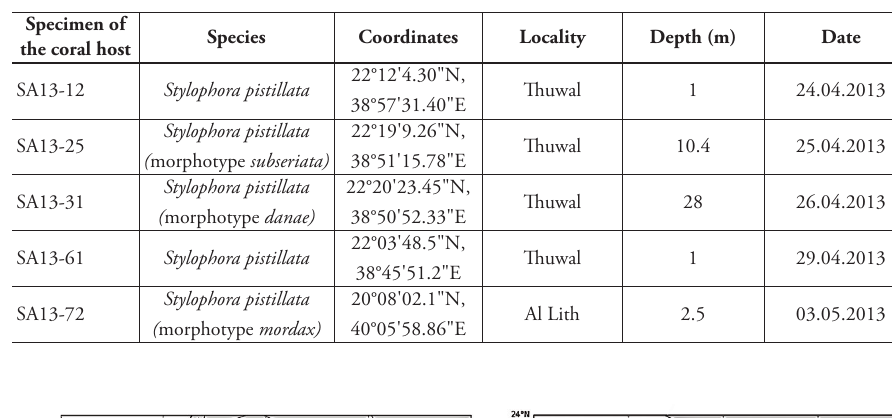
Table 1. Sampling localities in the Red